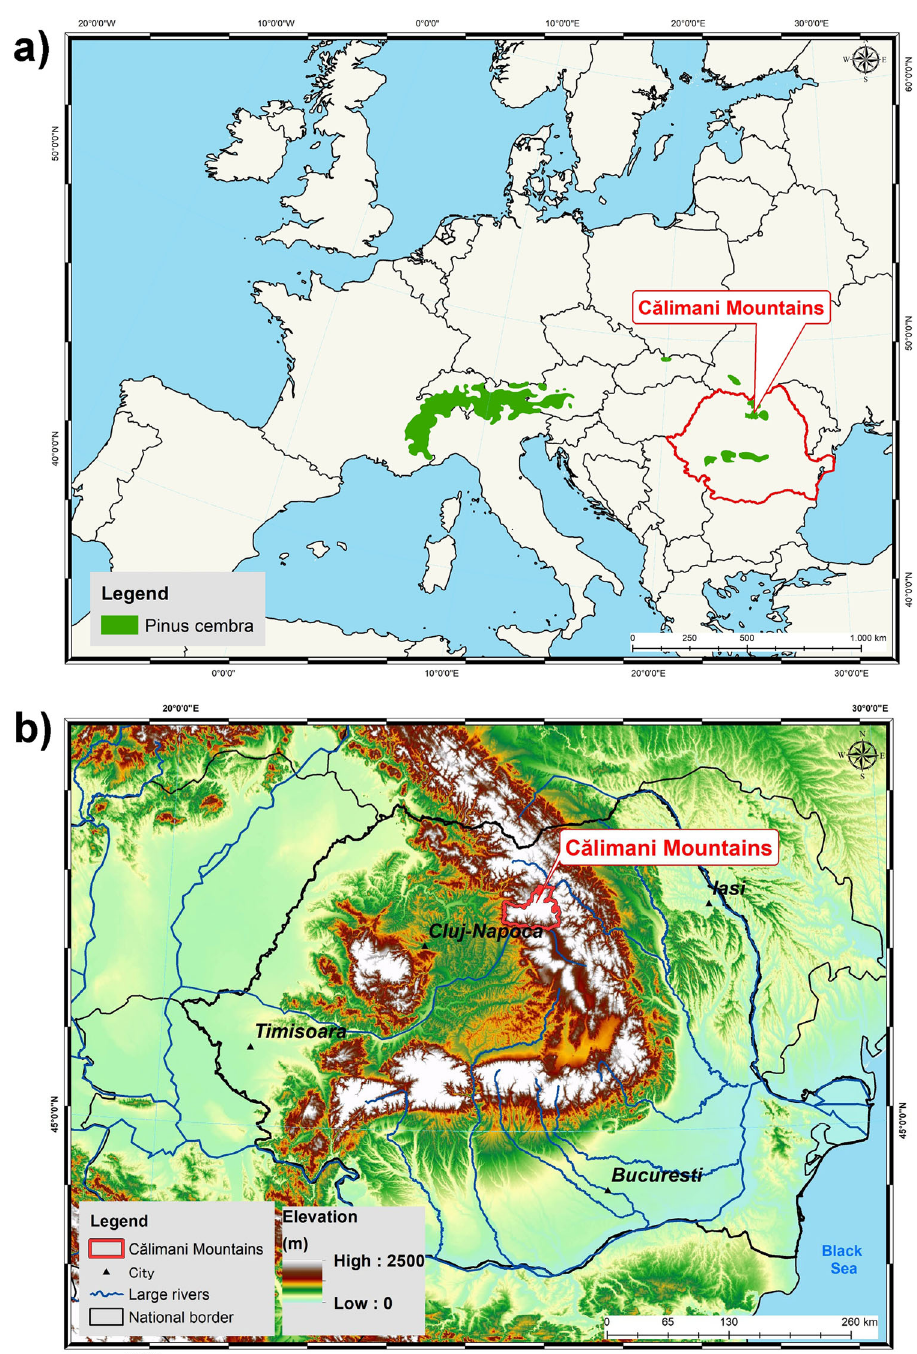
Fig. 1 Location of the investigation area. a Distribution of Pinus cembra in Europe 99 , and b topographic map of Romania showing the sampling